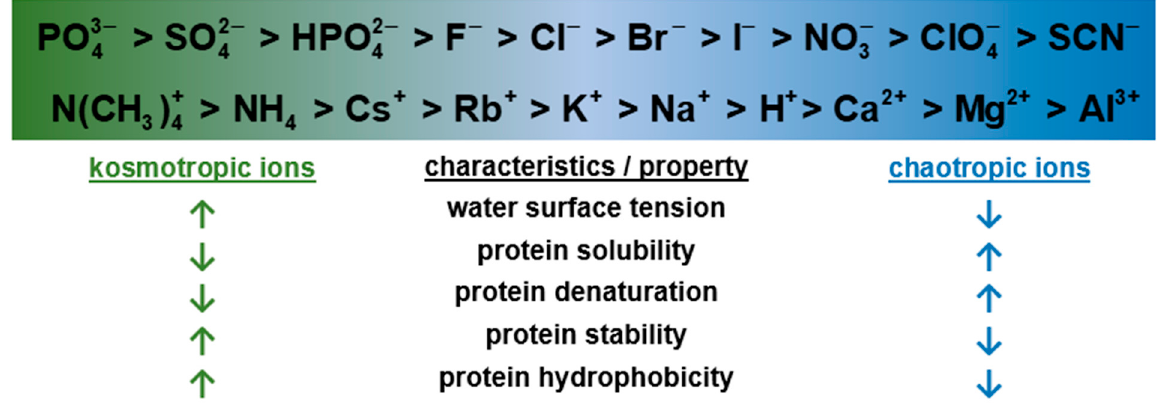
Figure 1. Hofmeister series of anions and cations and their influence on protein solution proper- ties.